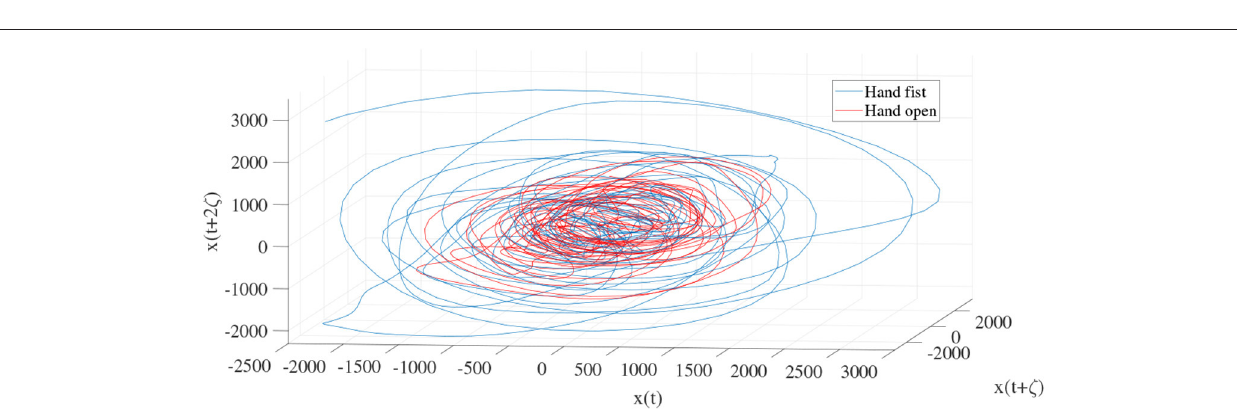
FIGURE 5 | Trajectories of an open hand and making a fist in the reconstructed phase space for channel CP5